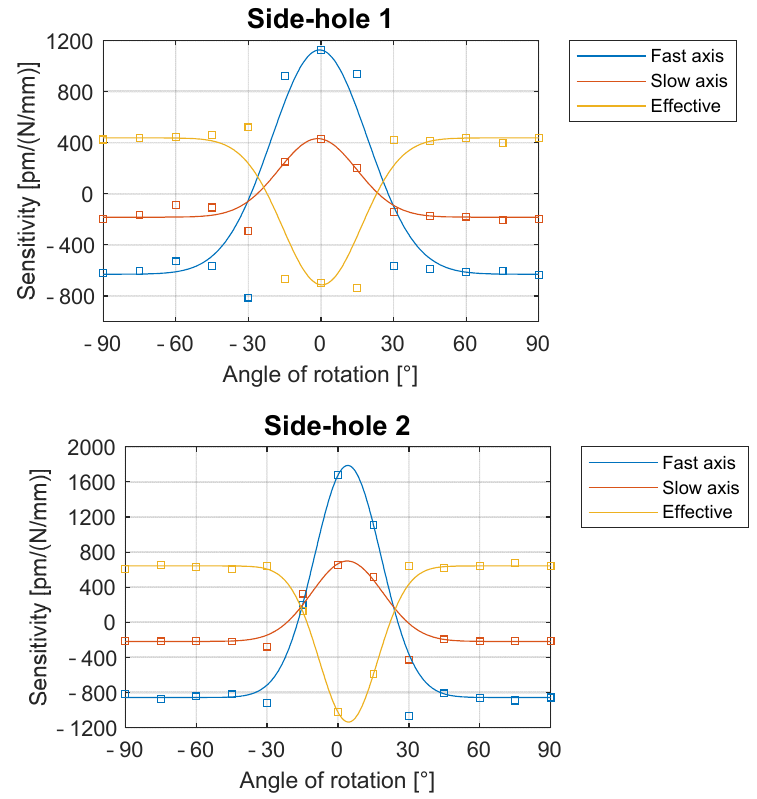
Figure 7. Transverse force sensitivity of the FBG sensor inscribed in side-hole fibers (SH1—top, SH2—bottom) vs. angle of rotation.